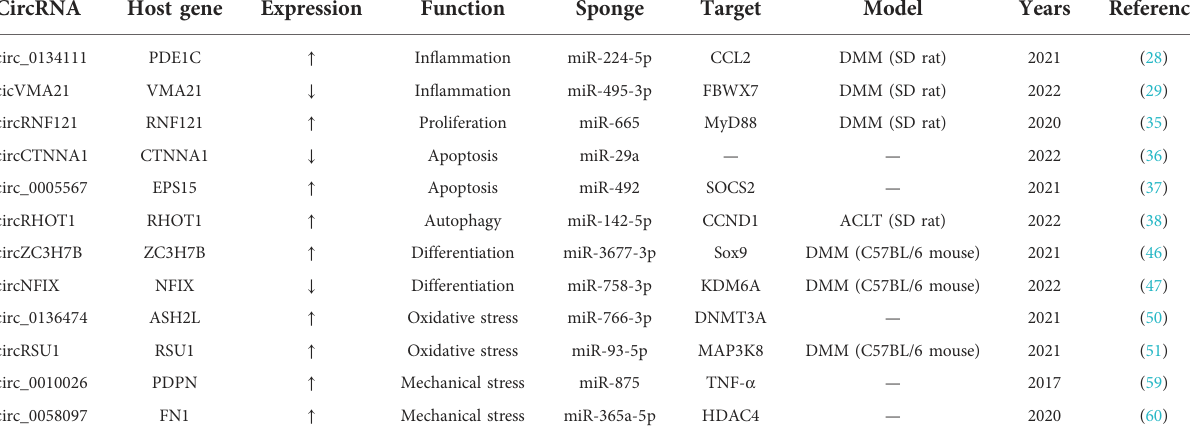
TABLE 1 CircRNAs involved in OA progression by intracellular ceRNA mechanism.